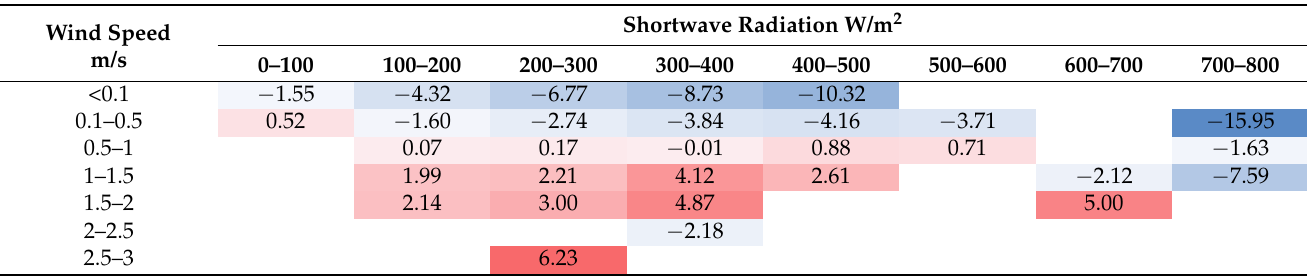
Table 4. Statistics of dTmrt results of various wind speed values and temperature ranges (air temperature range of 24–29 ◦ C).